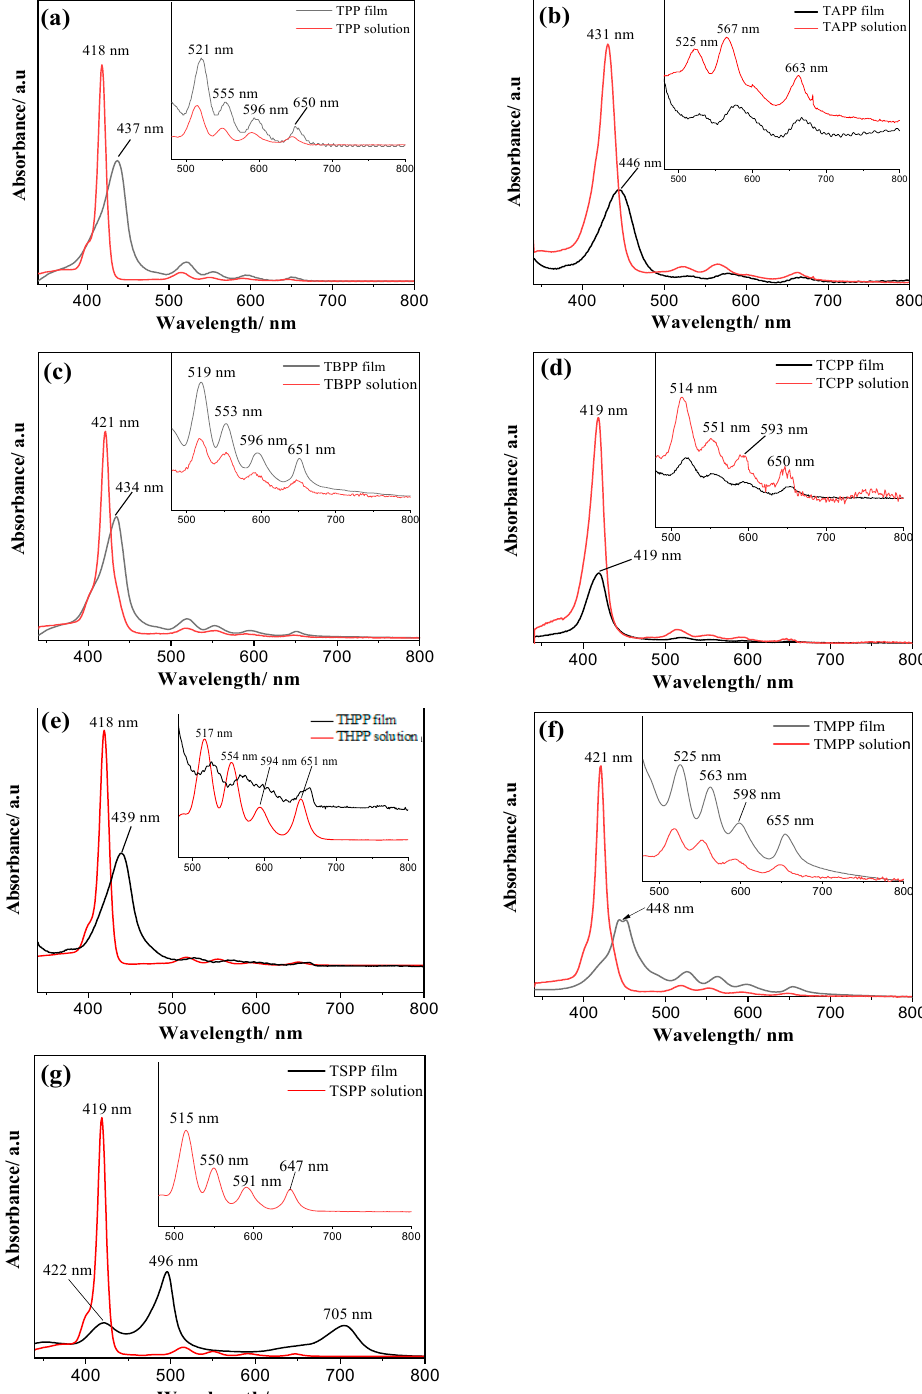
Figure 4. Absorbance spectrum of each porphyrin in film state and in solution with optimal solvents: ( a ) TPP in CH 2 Cl 2 , ( b ) TAPP in THF, ( c ) TBPP in CH 2 Cl 2 , ( d ) TCPP in CH 3 OH, ( e ) THPP in CH 3 OH, ( f ) TMPP in CH 2 Cl 2 , ( g ) TSPP in DMF.